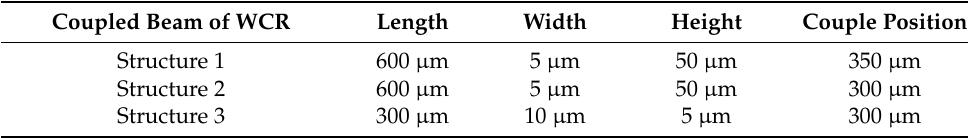
Where Structure 1 uses folded beams, the element size of which is given in Figure A1.